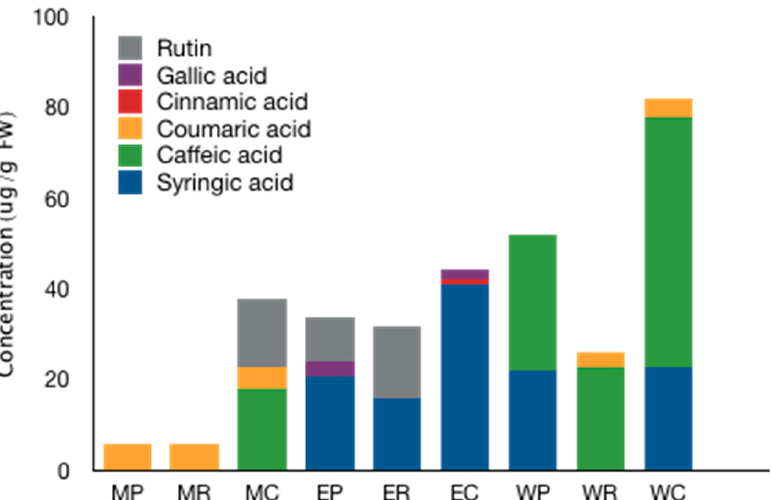
Figure 3. The chemical composition profile of Argylia radiata extracts determined by UPLC- MS/MS.